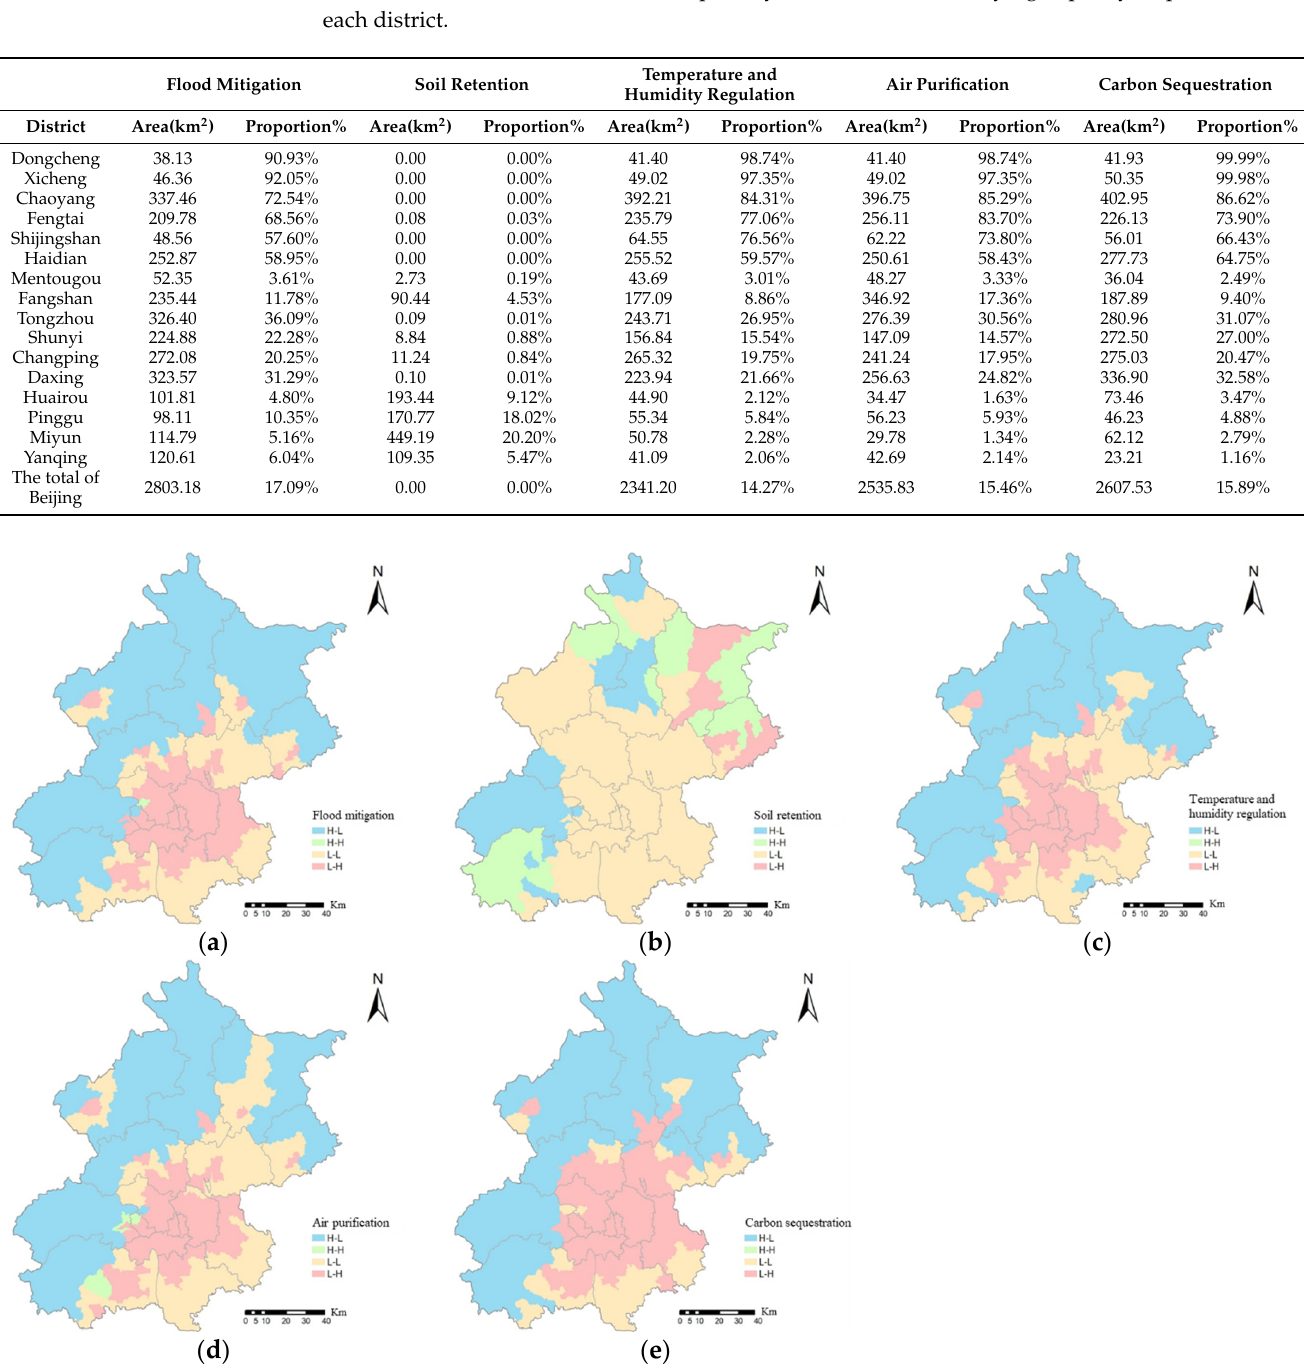
Figure 6. The (mis)match of ES supply and demand in subdistrict scale.